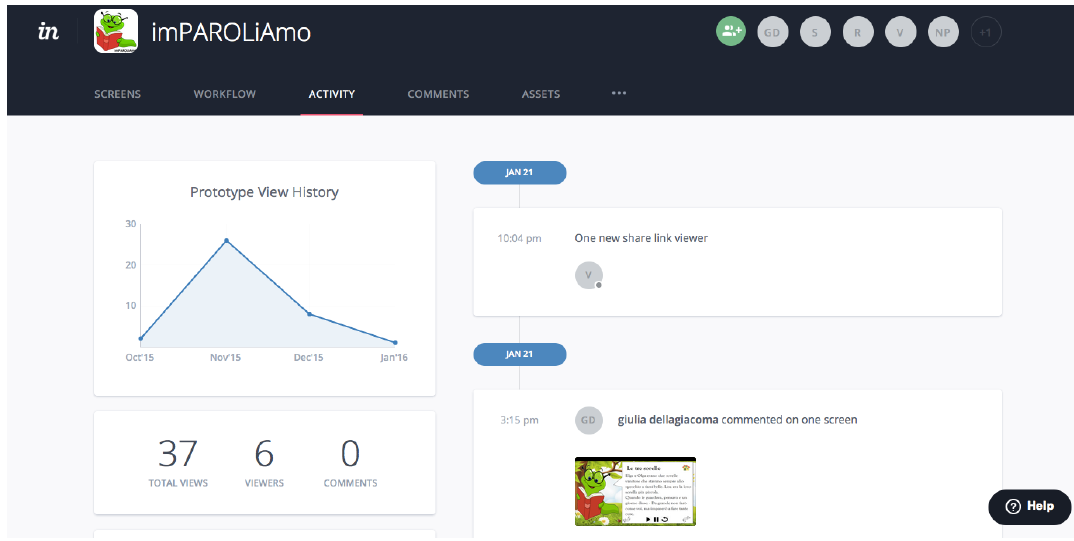
Figure 1 . Screenshot showing data analytics regarding activities conducted during a students’ project